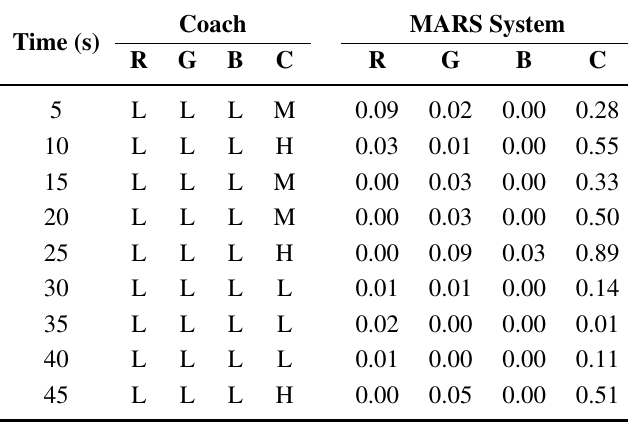
Table 5. Session C , coach and system assessment.